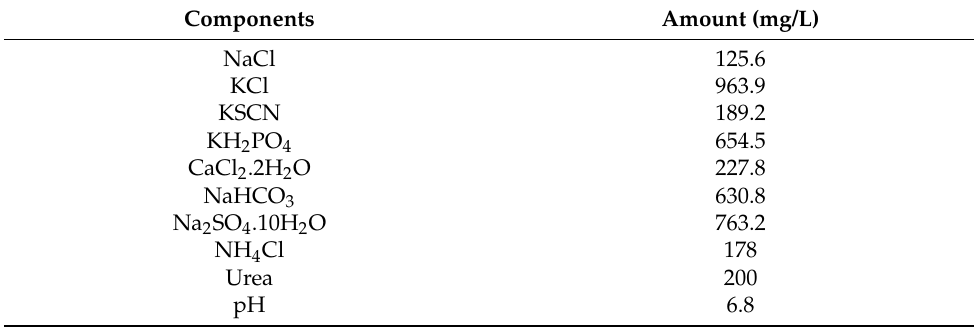
Table 1. Synthetic saliva composition used in fluoride release test